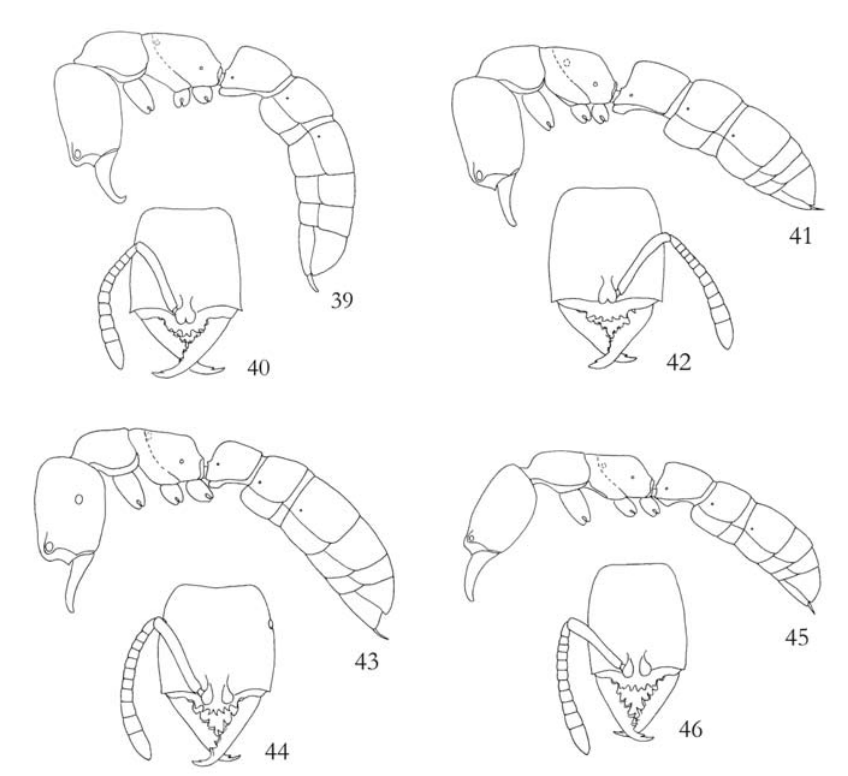
Figs. 39-46. 39-40: Worker of Amblyopone papuana Taylor; 39. Head and body in profile view; 40. Head in full-face view. (Drawn from Antweb images). Figs. 41-42: Worker of Amblyopone minuta (Forel); 41. Head and body in profile view; 42. Head in full-face view. (Drawn from Antweb images). 43-44: Worker of Amblyopone ophthalmica Baroni Urbani; 43. Head and body in profile view; 44. Head in full-face view. (Drawn from Antweb images). 45-46: Worker of Amblyopone boltoni Bharti et Wachkoo; 45. Head and body in profile view; 46. Head in full-face view. (Drawn from Antweb